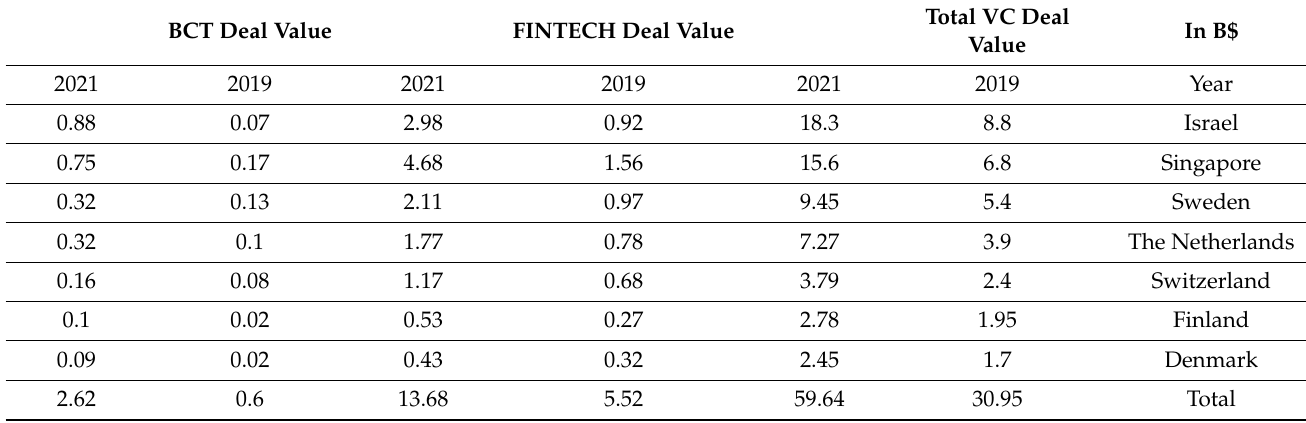
Table 2. VCF deal value 2021 vs. 2019.